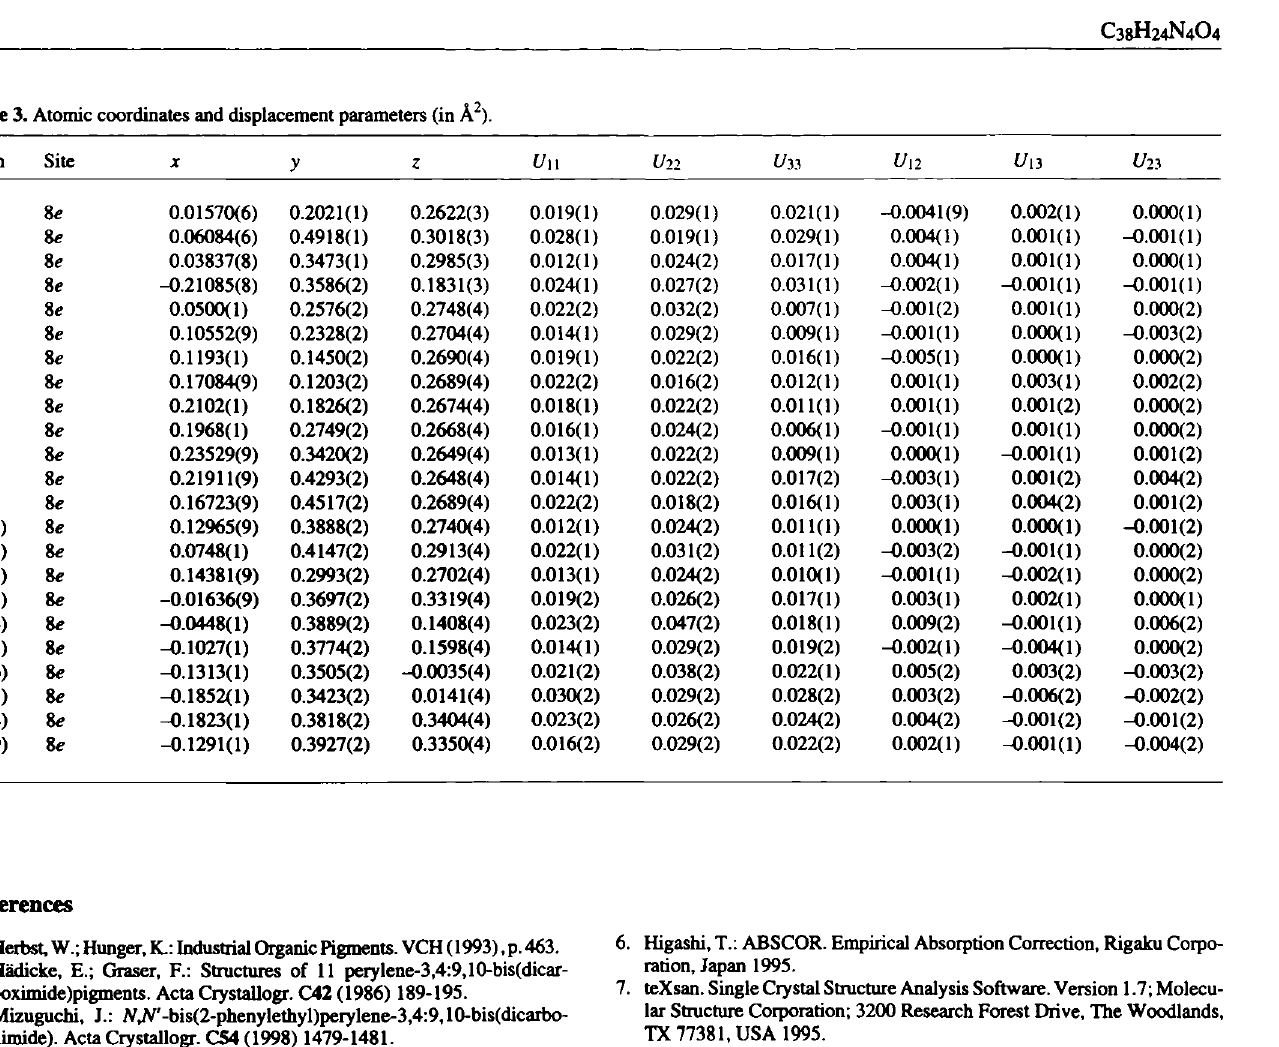
Table 3. Atomic coordinates and displacement parameters (in Â 2